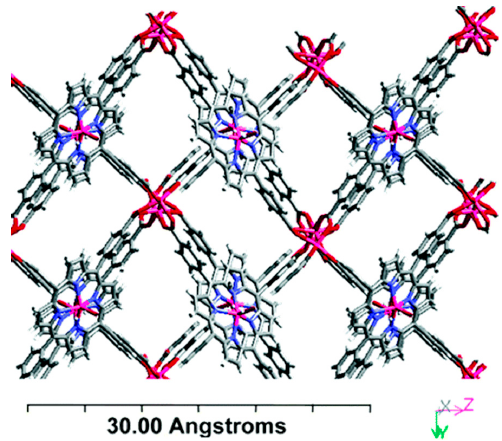
Figure 2. Schematic representation of the PIZA-3 Por-MOF viewed along the [1,0,0] direction of the unit cell. Solvent and coordinated N , N ′ -dimethylformamide molecules have been removed for clarity. Reprinted (adapted) with permission from [23]. Copyright (2005) American Chemical Society.